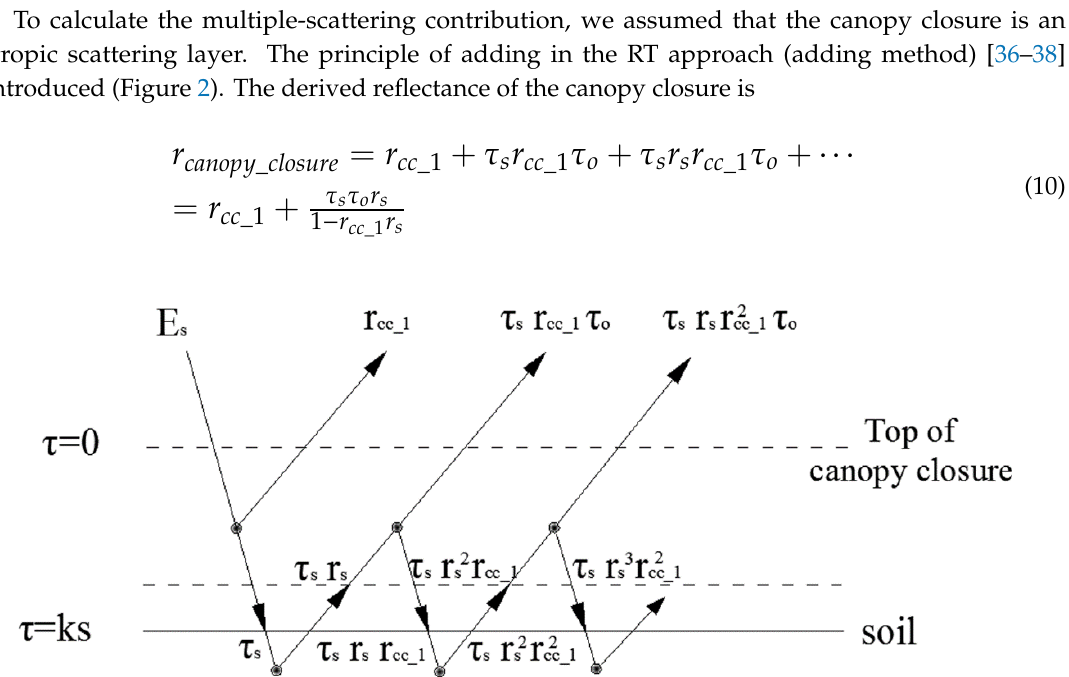
τ o is the transmittance of the